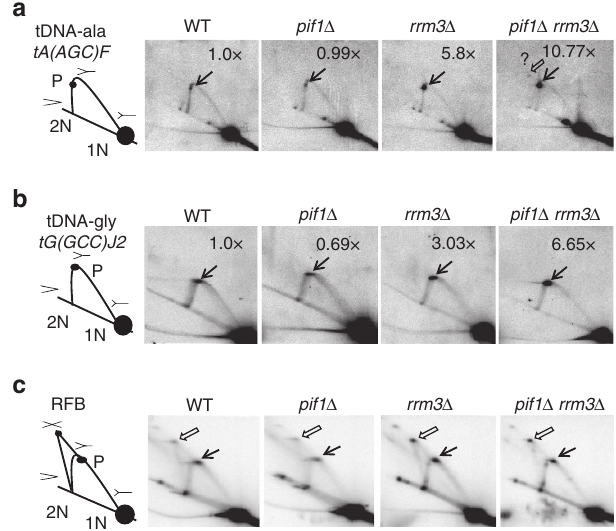
Figure 2 | Forks stall but do not arrest at tDNAs in the absence of Pif1 family DNA helicases. DNA from asynchronous WT, pif1 D , rrm3 D or pif1 D rrm3 D cells was digested with restriction enzymes and analysed by two- dimensional (2D) gel electrophoresis and Southern hybridization. ( a – c ) Schematics of the results from 2D gel analysis for each region are shown to the left of the Southern blots of 2D gels: 1N marks the position of non-replicating linear fragments; 2N is position of almost fully replicated 1N fragments right before sister chromatids separate; P, replication pause; X, converged forks. Southern blots were hybridized using 32 P-labelled probes to detect the following regions (see Supplementary Table 10 for primers for probes): ( a ) tDNA ala HO (BglII), ( b ) tDNA gly HO (EcoRI) and ( c ) rDNA (BglII fragment containing RFB). Black arrows indicate sites of fork pausing and open arrows indicate sites of converged forks. In a , there is a faint signal at tDNA ala in pif1 D rrm3 D cells that might be due to converged forks; this signal is marked with an open arrow and a question mark. In a , b , the signal at the pause was quantified (see Supplementary Fig. 1 for details) and normalized to the pause signal in WT cells to obtain the relative fold change (top right corner of each Southern blot). The average fold difference of 2D gels from two independent biological replicates for tDNA ala is shown in Supplementary Fig. 1. c is a 2D gel from the same DNA preparation used in b that was hybridized with an rDNA probe to visualize forks converged at the